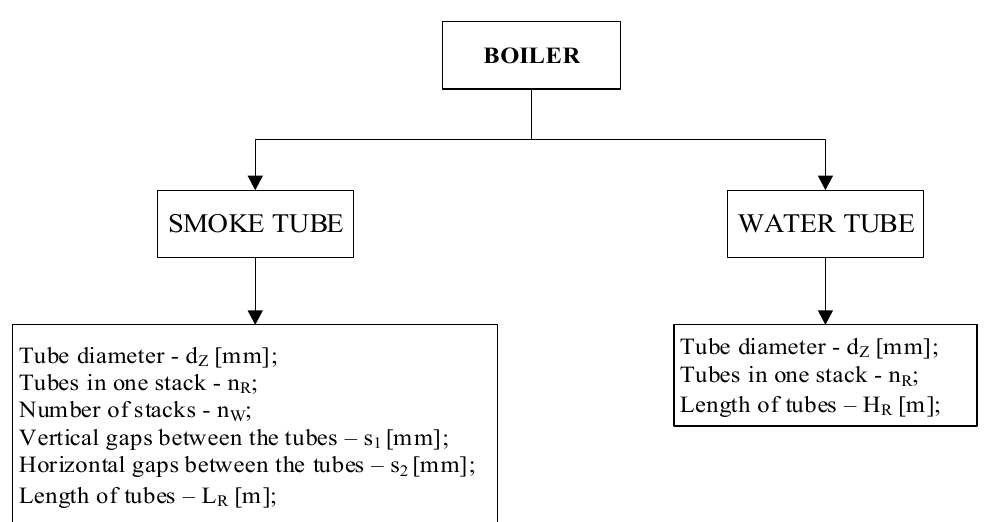
Figure 3. Algorithm to establish the structural parameters of the EGB.